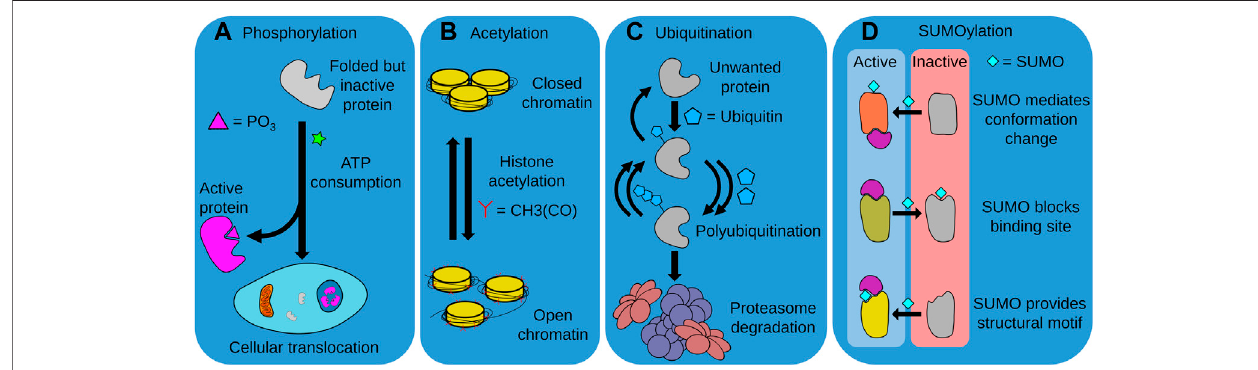
FIGURE 4 | Post-translational modi fi cations (PTMs). Distinct PTMs such as phosphorylation, acetylation, ubiquitination, and SUMOylation modulate the activity, intracellular localization and degradation of numerous proteins, determining cellular function and organismal longevity. (A) The ATP-consuming process of phosphorylationisrequiredfortheactivityofmanyproteins,eitherthroughprovidingafunctionalchemicalmoiety,orbyallowingtheproteintotranslocatetotherequired cellularcompartment. (B) Acetylationisalsorequiredforthefunctionofvariousproteins,andisparticularlyimportantforcorrectchromatinfunction.Inthisinstance, histone acetylation is required for chromatin opening and access to DNA by the cell. (C) The ubiquitination of unwanted proteins marks them for recognition and degradation by the UPS. This often requires repeated units of ubiquitin to be successively added to a growing polyubiquitin chain. The balance between ubiquitination and deubiquitination can thus control and regulate the composition of the proteome. (D) SUMOylation can both activate or deactivate modi fi ed proteins. SUMOylation can trigger conformational changes that allow proteins to interact with their biological substrates, block binding sites to prevent substrate interaction, or act as a component of a structural motif to enable recognition of the modi fi ed